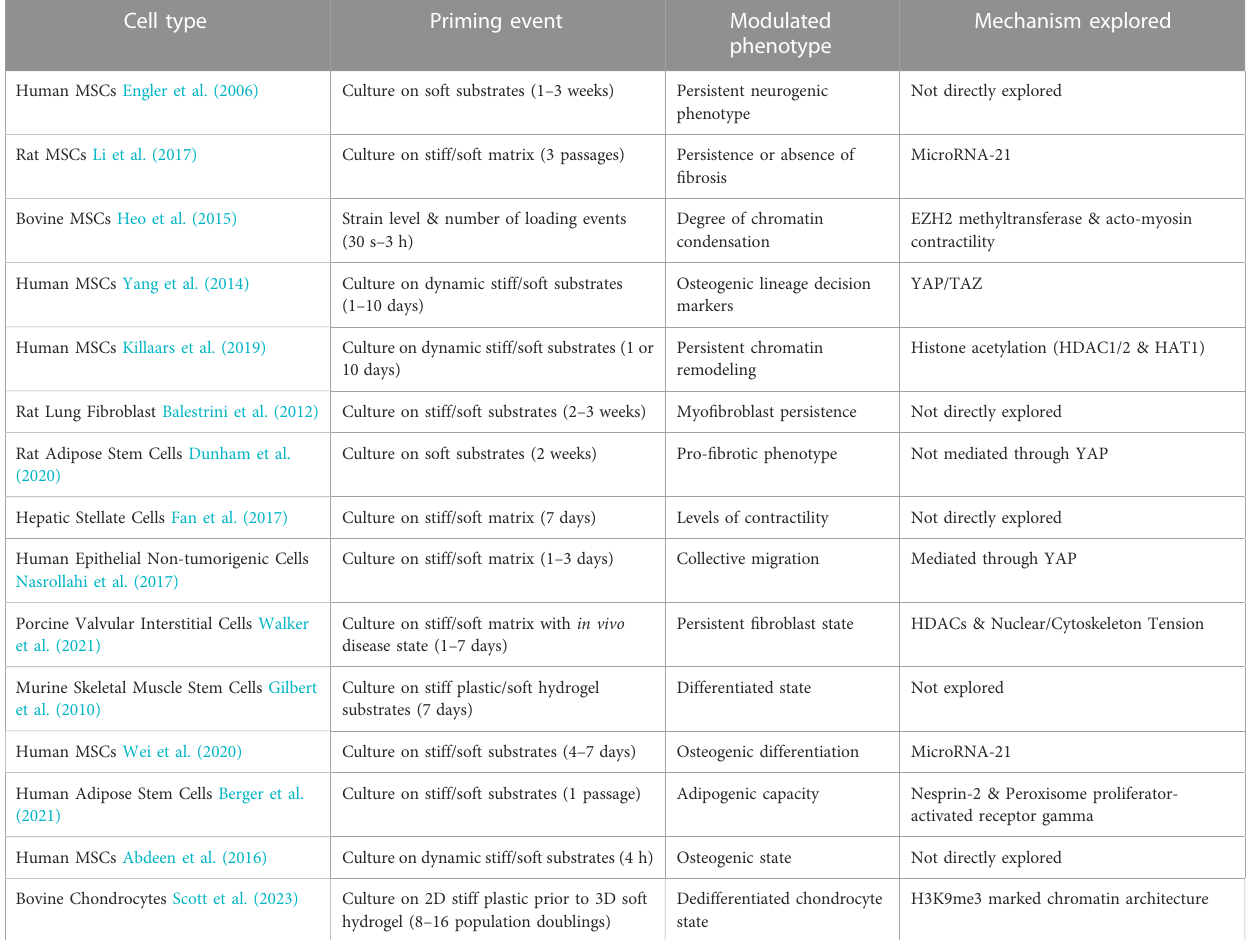
TABLE 1 Studies exploring mechanical memory in different cell